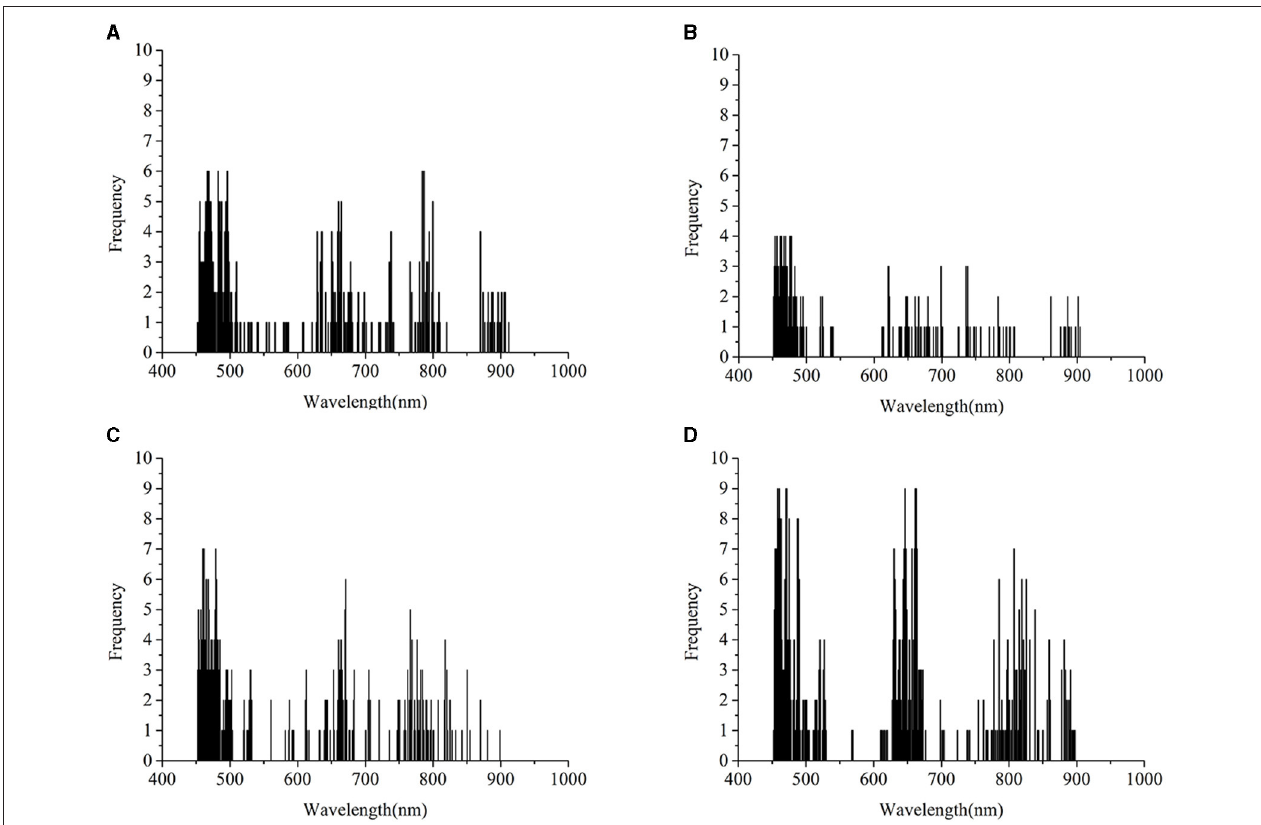
FIGURE 7 | Saliency map after transfer learning regarding the rice variety 01 (Zhongzheyou1), which is based on the results of 01 after achieving the transfer task 03 → 01 with deep CORAL. (A–D) Represent the key wavelength ranges captured by CNN to correctly classify rice diseases with classes 0 (healthy samples, CK), 1 (rice leaf blight, RLB), 2 (rice blast, RB), and 3 (rice sheath blight, RSB),